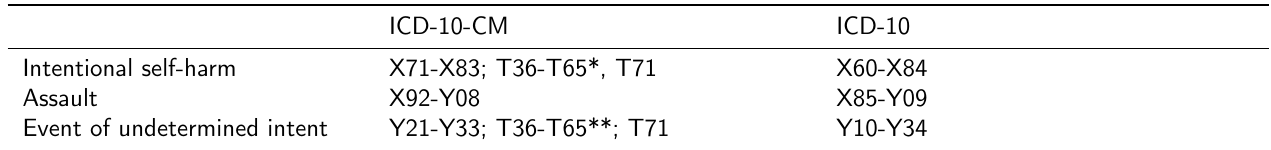
Table 3: Example of discrepancy between ICD-10-CM and ICD-10 at 3-character